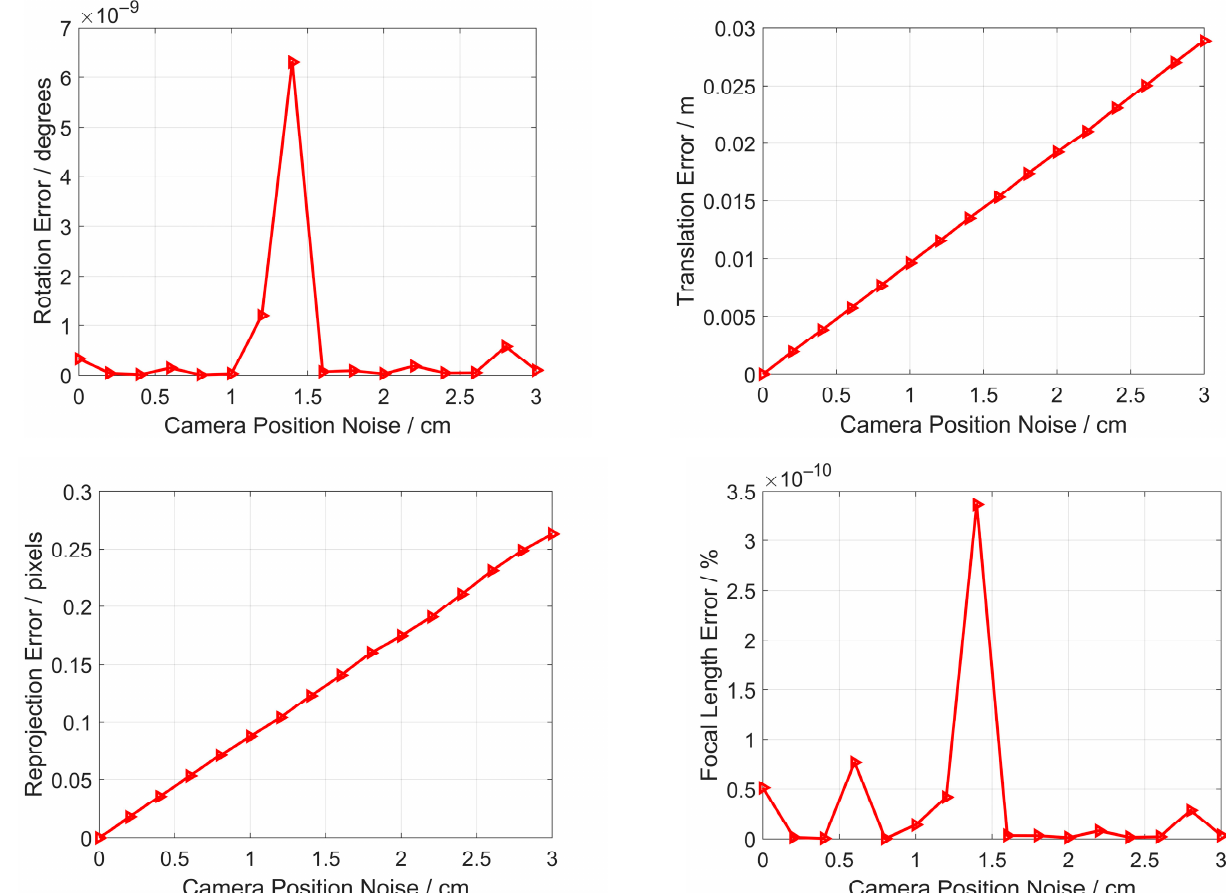
Figure 6. Robustness to camera position noise for the rotation error ( Top left ), translation error ( Top right ), reprojection error ( Bo tt om left ) and focal length error ( Bo tt om right ).